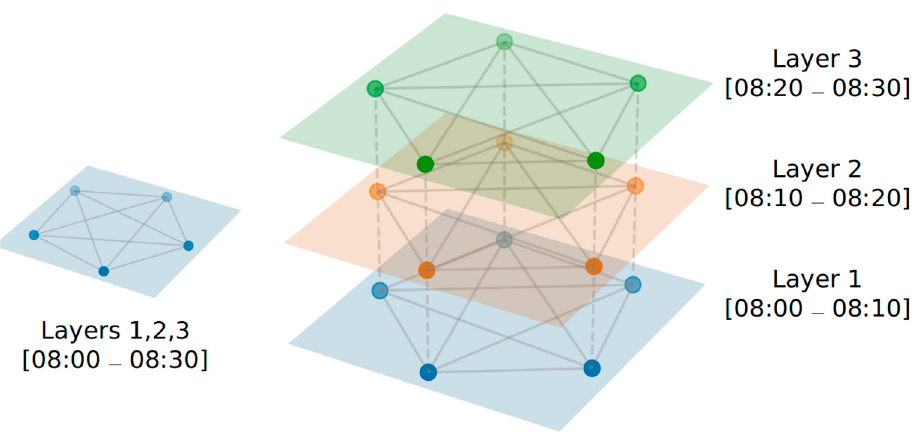
Figure 8. Representation of a single and of a multi-layer network. With a single network layer, the temporal dimension is not considered, giving rise to a single connected component spanning for 30 min. Instead, the multi-layer network shows the active links during each of the 3 layers of 10 min duration.